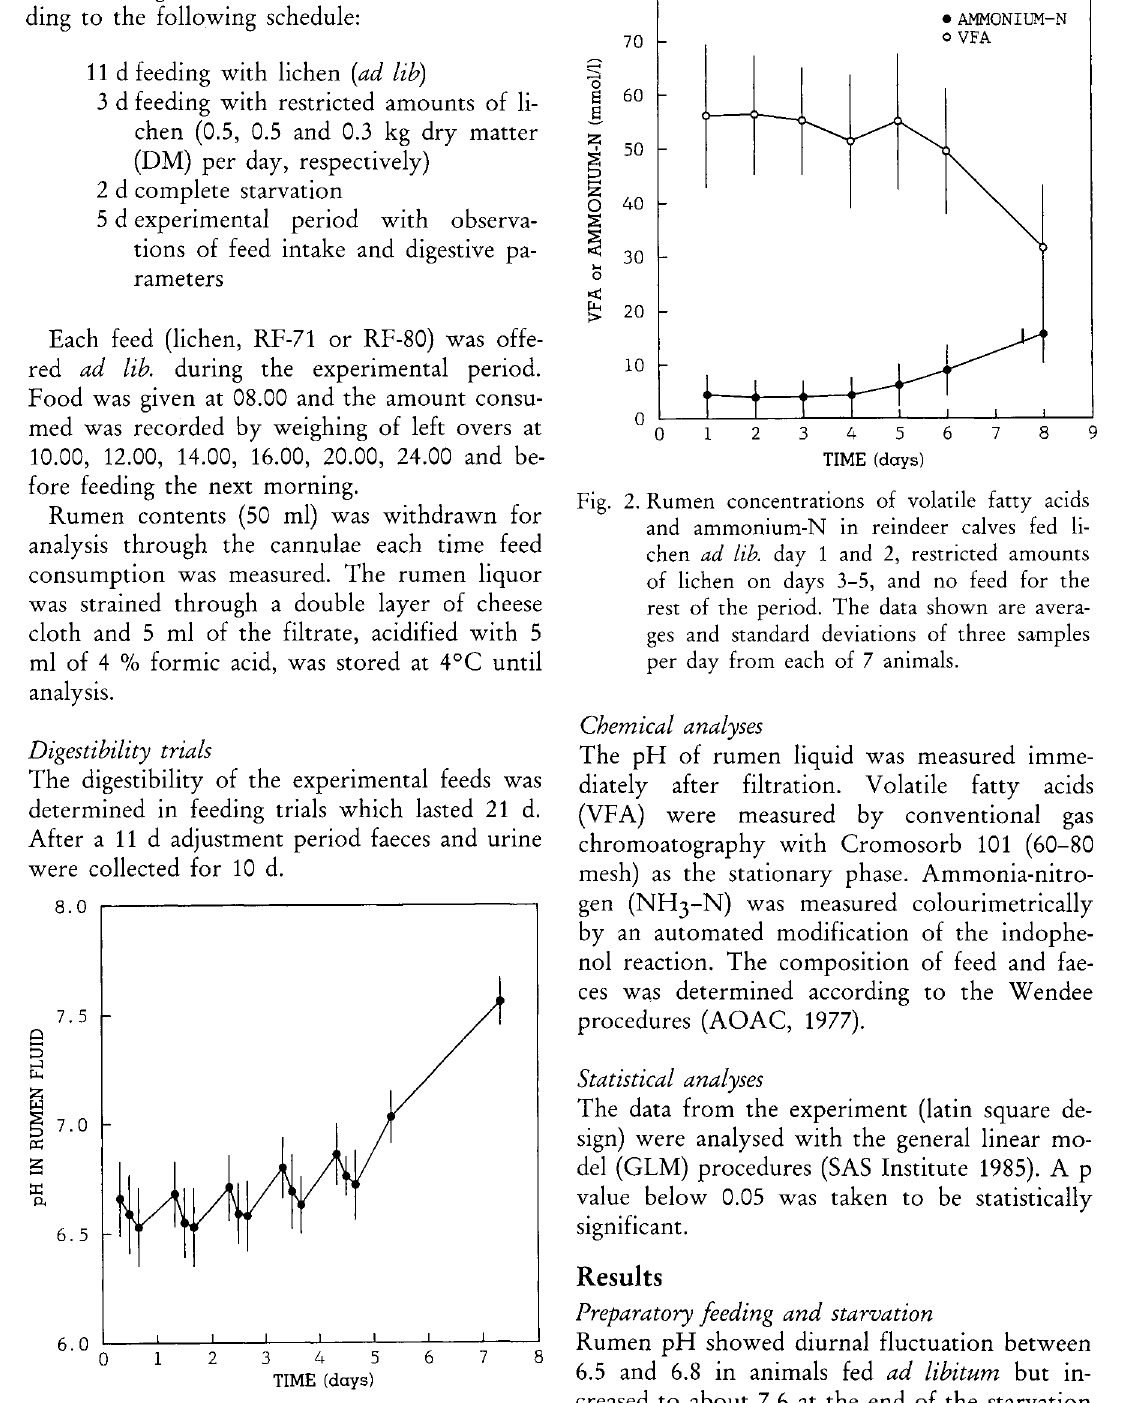
Fig. 1. Rumen pH in reindeer calves fed lichen ad lib. day 1 and 2, restricted amounts of lichen on days 3-5, and no feed for the rest of the period. Average and standard deviation of ob servations from 7 calves.